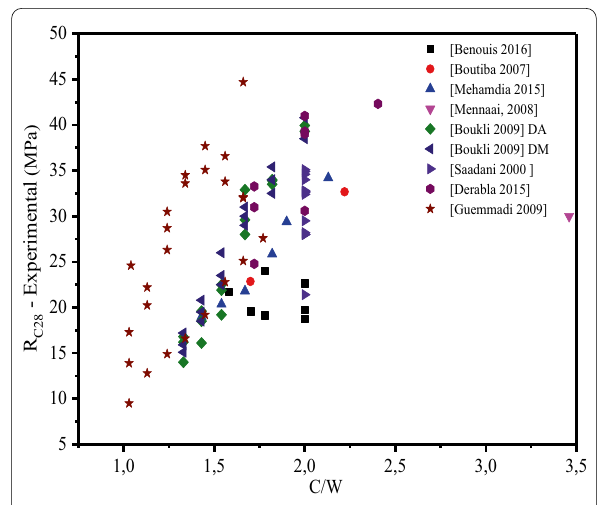
Fig. 7 Effect of the ratio C / W on R C28 (all collected